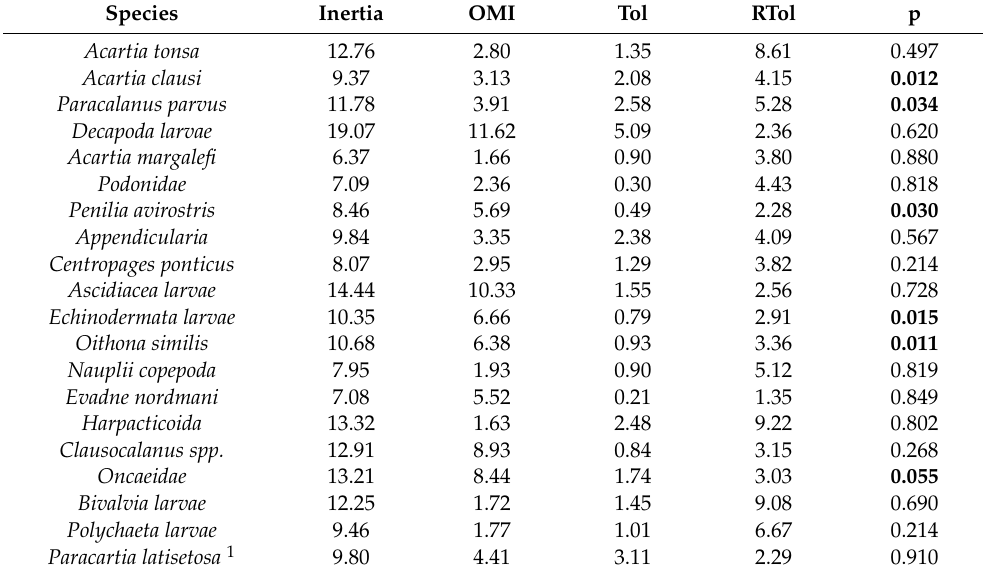
Table 5. Niche parameters of the 20 most abundant zooplankton taxa in the Lagoon of Venice during 2014–2017 (outlying mean index (OMI) analysis). The inertia of each species, OMI, the tolerance index (Tol), and the residual tolerance index (RTol) are indicated. The last column (p) represents the percentage of random permutations (out of 1000) that yielded a higher value than the observed OMI (significant cases are in bold, p <